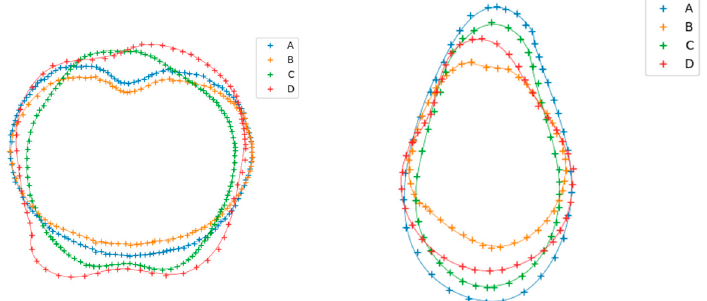
Figure 1. Depiction of the different cross sections for tomatoes (left) and avocadoes (right) showing the spline representations of the outer edges.